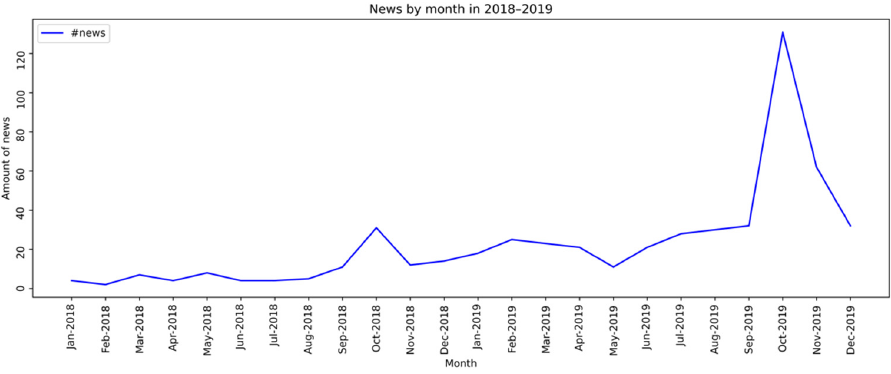
Figure 3. News month by month between 2018 and 2019 about syphilis.